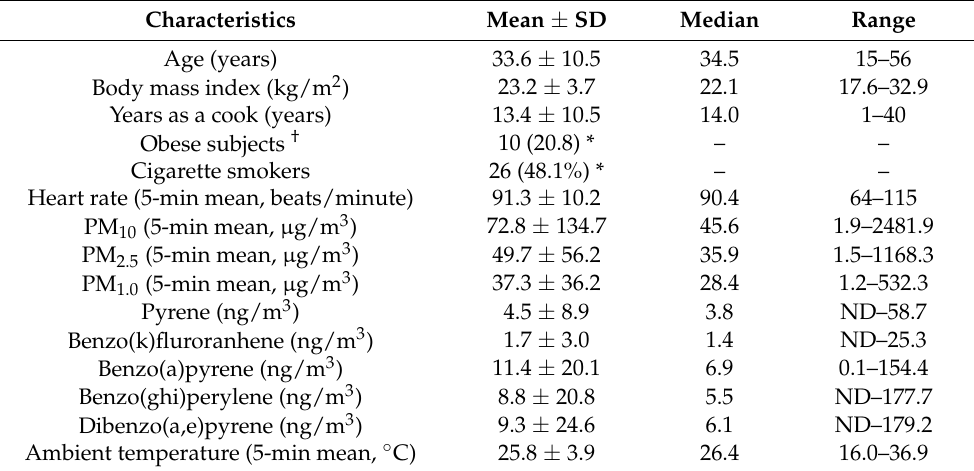
Table 1. Personal characteristics and environmental exposures of cooks ( n =